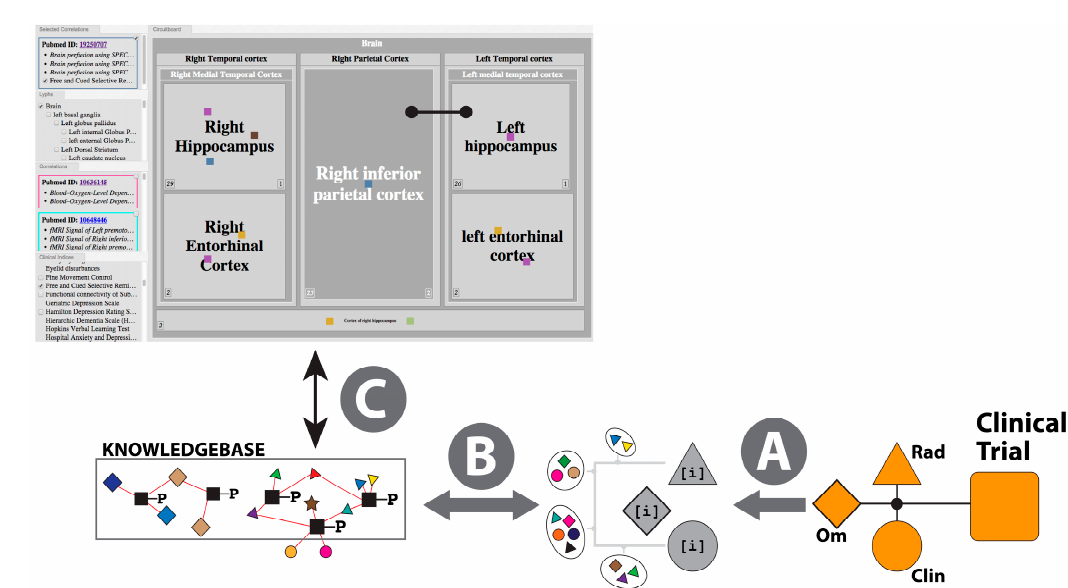
Figure 5. Workflow for the interpretation (Step B ) of results from clustering analysis of NDD patient data (Step A ); through the application of physiology route calculations and visualization in ApiNATOMY (Step C ). bottom right: Triangle represent radiological measurements; Circle represent clinical indices, Diamond represent “omic” indices. The orange color is meant to describe the generic character of the abovementioned dimensions. In the other parts of the graphic, the various colors in the shapes are representing the values that are taken by those dimensions in a specific context (e.g., individuals). The P is an abbreviation for Publication.